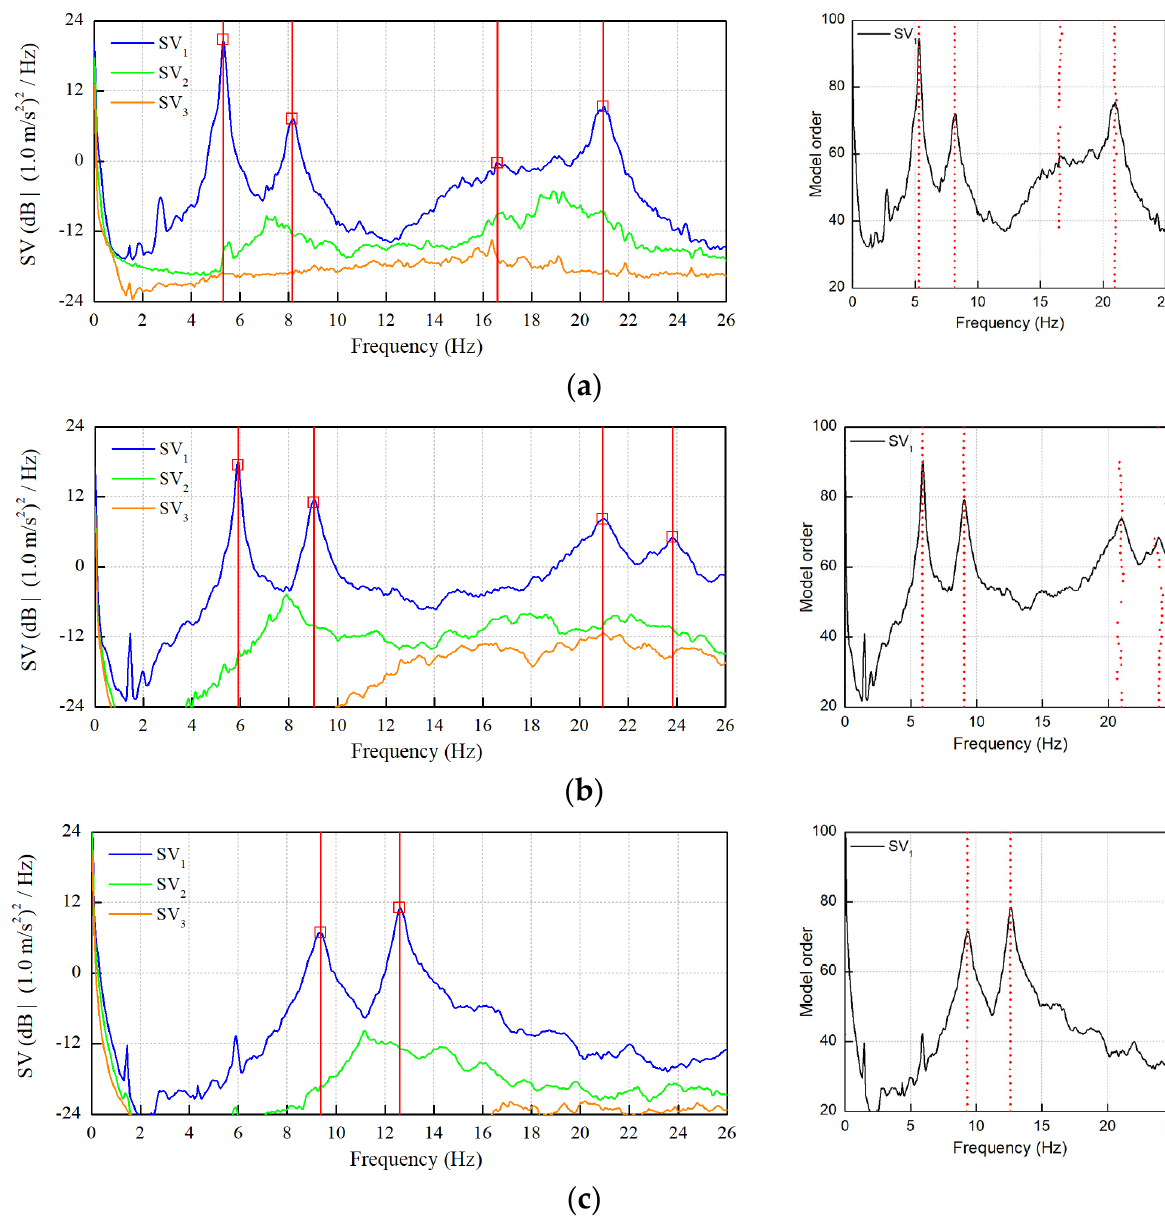
Figure 9. Identification of natural frequencies with FDD and SSI techniques: ( a ) Span S1, ( b ) Span S2, and ( c ) Span S3.